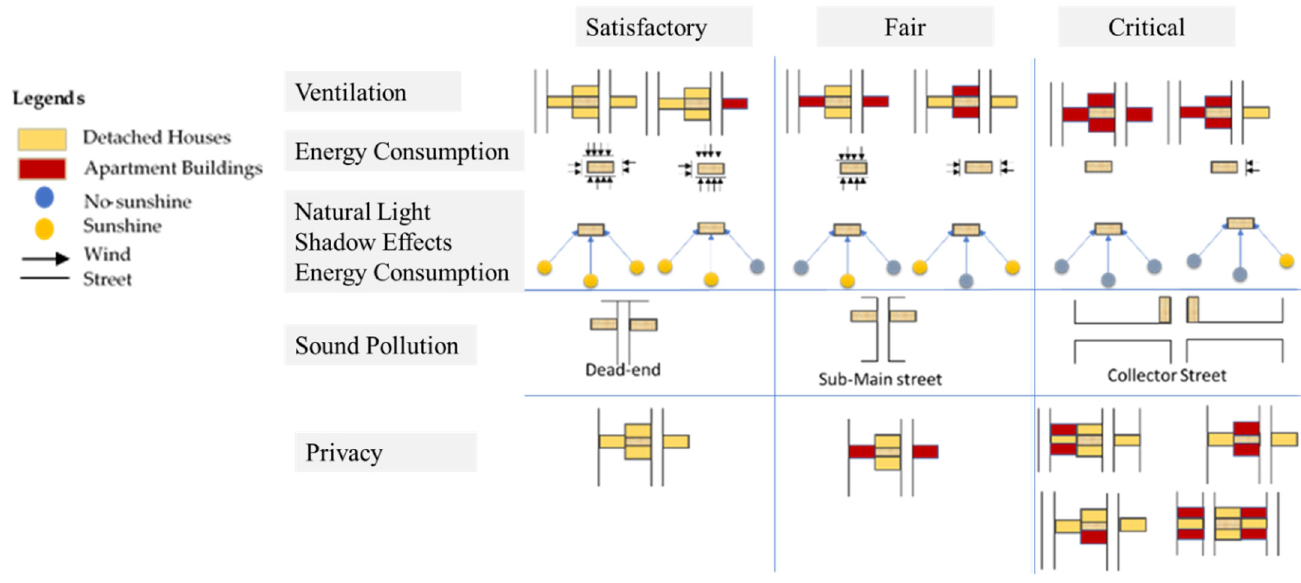
Figure 9. Categorizing of issues based on single impacts.